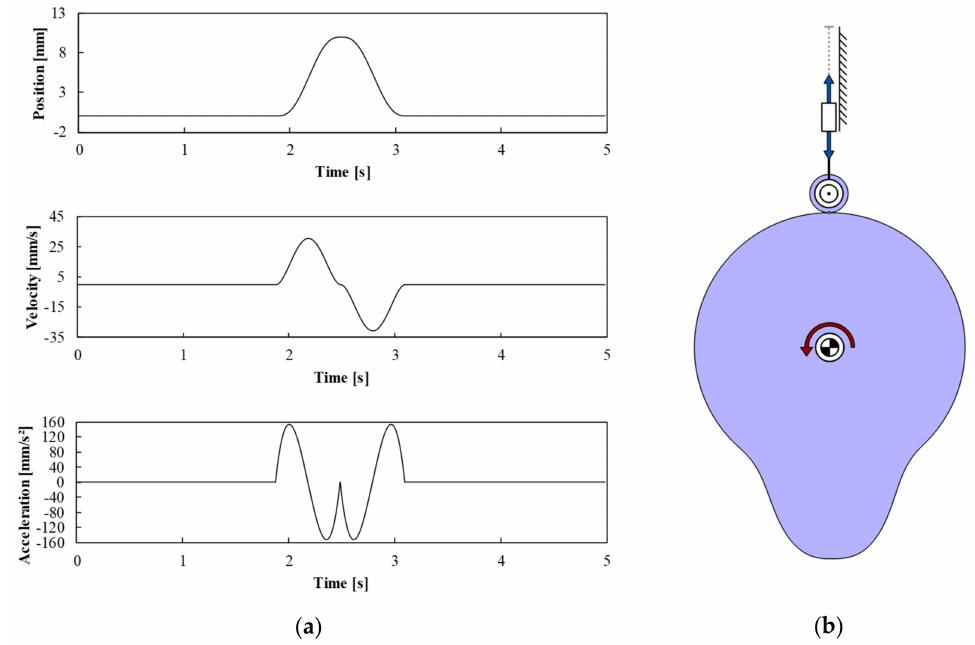
Figure 4. ( a ) Output motion of the sliding follower, ( b )Resulting cam mechanism with constant input